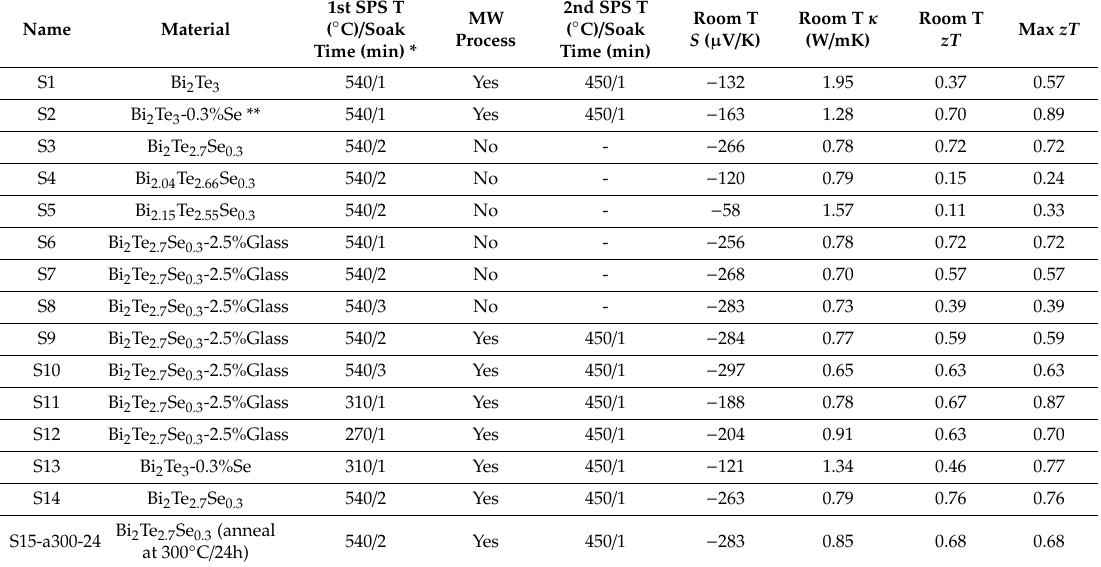
* Table abbreviations: SPS: spark plasma sintering, T: temperature, MW: microwave. ** 0.3% Se is equal to 6 at. %